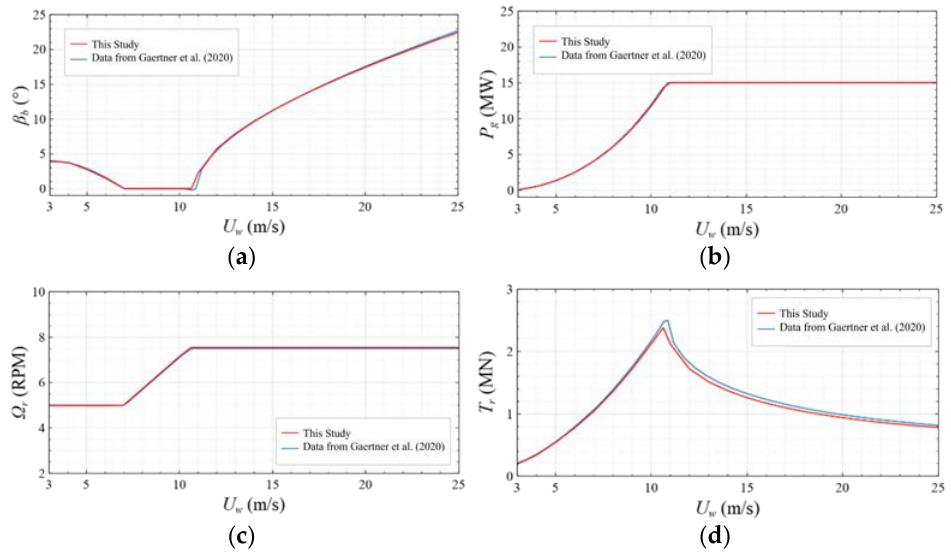
Figure 4. Comparison of ( a ) blade pitch angle, ( b ) generator power, ( c ) rotor speed, and ( d ) rotor thrust force between this study and [18].